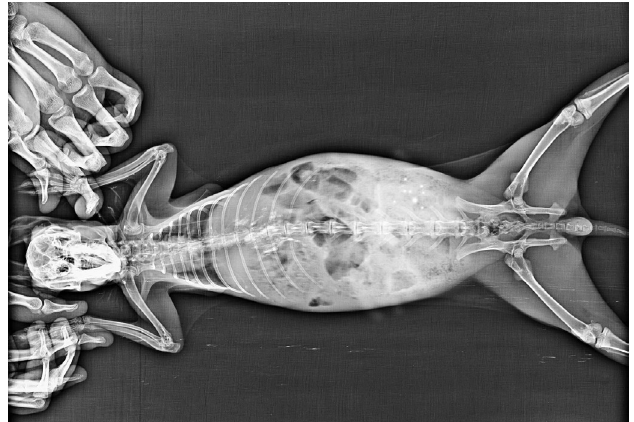
FIGURE 10 - X-ray image of formulation containing lactose with barium sulphate after four